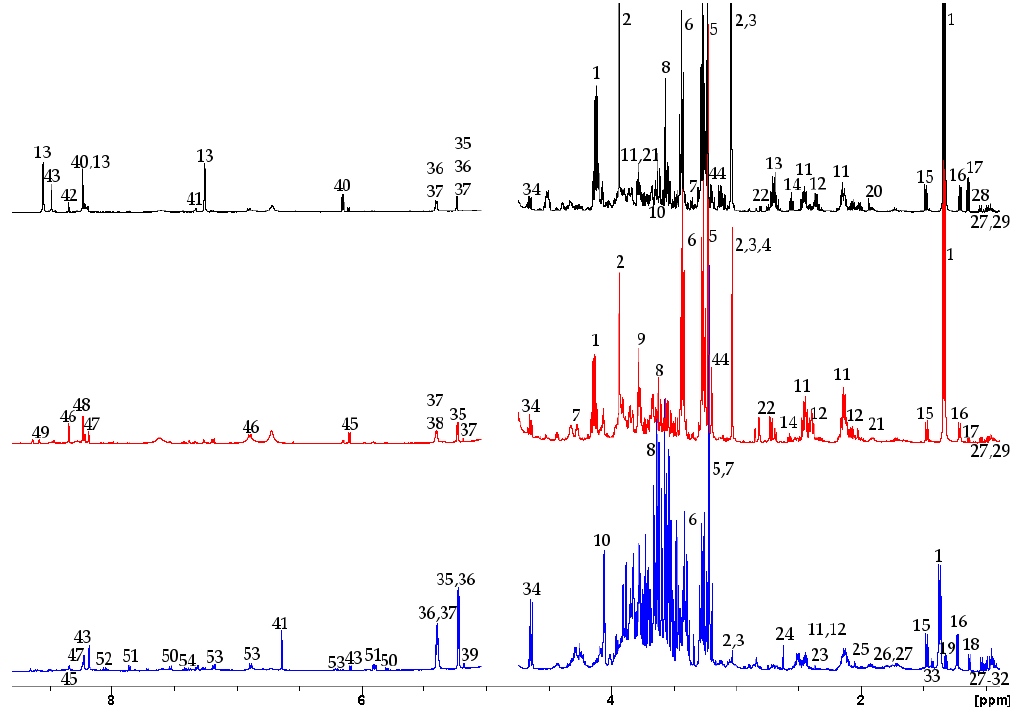
Figure 1. Representative 1 H-NMR spectra of aqueous extracts of skeletal muscle (top/black), heart (middle/red), and liver (bottom/blue) from hatchling loggerhead sea turtles ( Caretta caretta ). The y axis is indicative of peak intensity, which correlates to concentration. Peaks 1, 2, 3, and 5 are truncated. The water peak has been removed. Labeled peaks are as follows: (1) lactate, (2) creatine, (3) phosphocreatine, (4) creatinine, (5) phosphocholine, (6) taurine, (7) glycerophosphocholine, (8) glycine, (9) glutathione, (10) myo-inositol, (11) glutamine, (12) glutamate, (13) carnosine, (14) beta- alanine, (15) alanine, (16) 3-hydroxybutyrate, (17) propylene glycol, (18) unknown, (19) threonine, (20) acetate, (21) homoserine, (22) aspartate, (23) pyruvate, (24) methylamine, (25) glycylproline, (26) arginine, (27) leucine, (28) valine, (29) isoleucine, (30) alloisoleucine, (31) 2-hydroxybutyrate, (32) 2- hydroxyvalerate, (33) alanine dimer, (34) beta-glucose, (35) alpha-glucose, (36) maltose, (37) ribose, (38) glycogen, (39) mannose, (40) inosine monophosphate, (41) histidine, (42) formate, (43) inosine, (44) choline, (45) adenosine triphosphate, (46) nicotinamide adenine dinucleotide, (47) adenine, (48) adenosine, (49) adenosine diphosphate, (50) uracil, (51) uridine, (52) cytidine, (53) tyrosine, (54) phenylalanine. The uncropped, labeled spectra are in Figures S2, S3, and S4 in Supplementary Materials. Table 1. Metabolites identified in the aqueous extracts of skeletal muscle, heart, and liver of hatchling loggerhead sea turtles ( Caretta caretta ) grouped by metabolite type. Key: Skeletal muscle (S), Heart (H), Liver (L); (*) Confirmed using 2D NMR +/- 1D 31 P NMR experiments, laboratory standards +/- predicted spectra (ACD SACD11/C+H Predictor and DB). (#) Metabolites that met the statistical significance threshold ( α = 0.05). Metabolite chemical shifts and multiplicities are provided in Table S1 in Supplementary Materials.